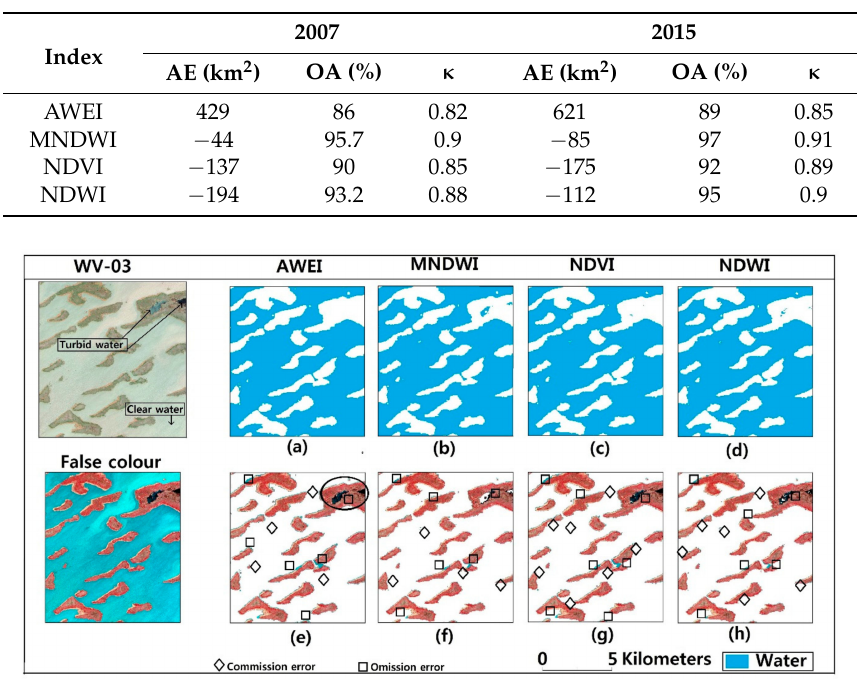
Figure 6. Comparison of the performance of AWEI, MNDWI, NDVI and NDWI on water extraction for the OLI image. ( a – d ) are binary images from AWEI, MNDWI, NDVI and NDWI respectively. ( e – h ) are water pixels overlaid on false composite image to highlight possible